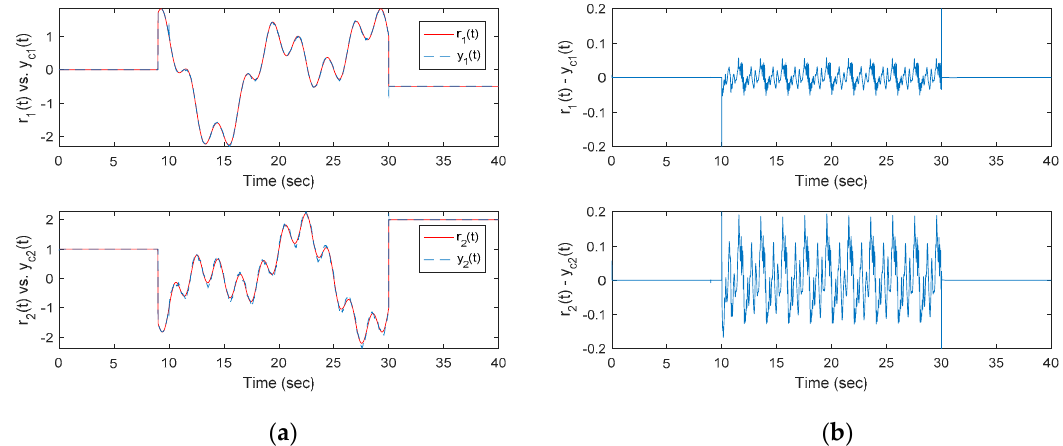
( ) d t (state-dependent disturbance inside) and ( b ) state-dependent 1 s